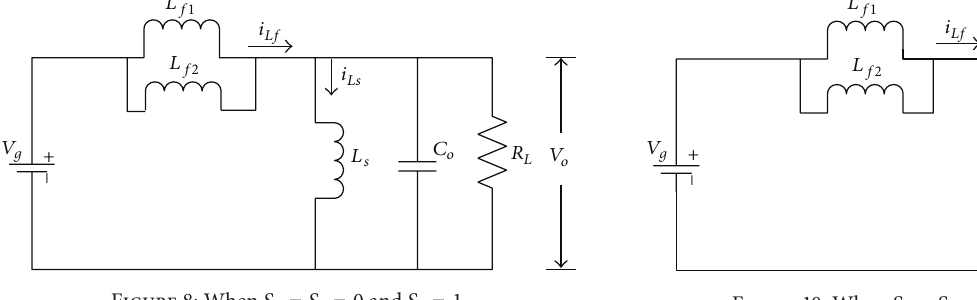
Figure 10: When 𝑆 1 = 𝑆 2 = 1 and 𝑆 3 = 1 or